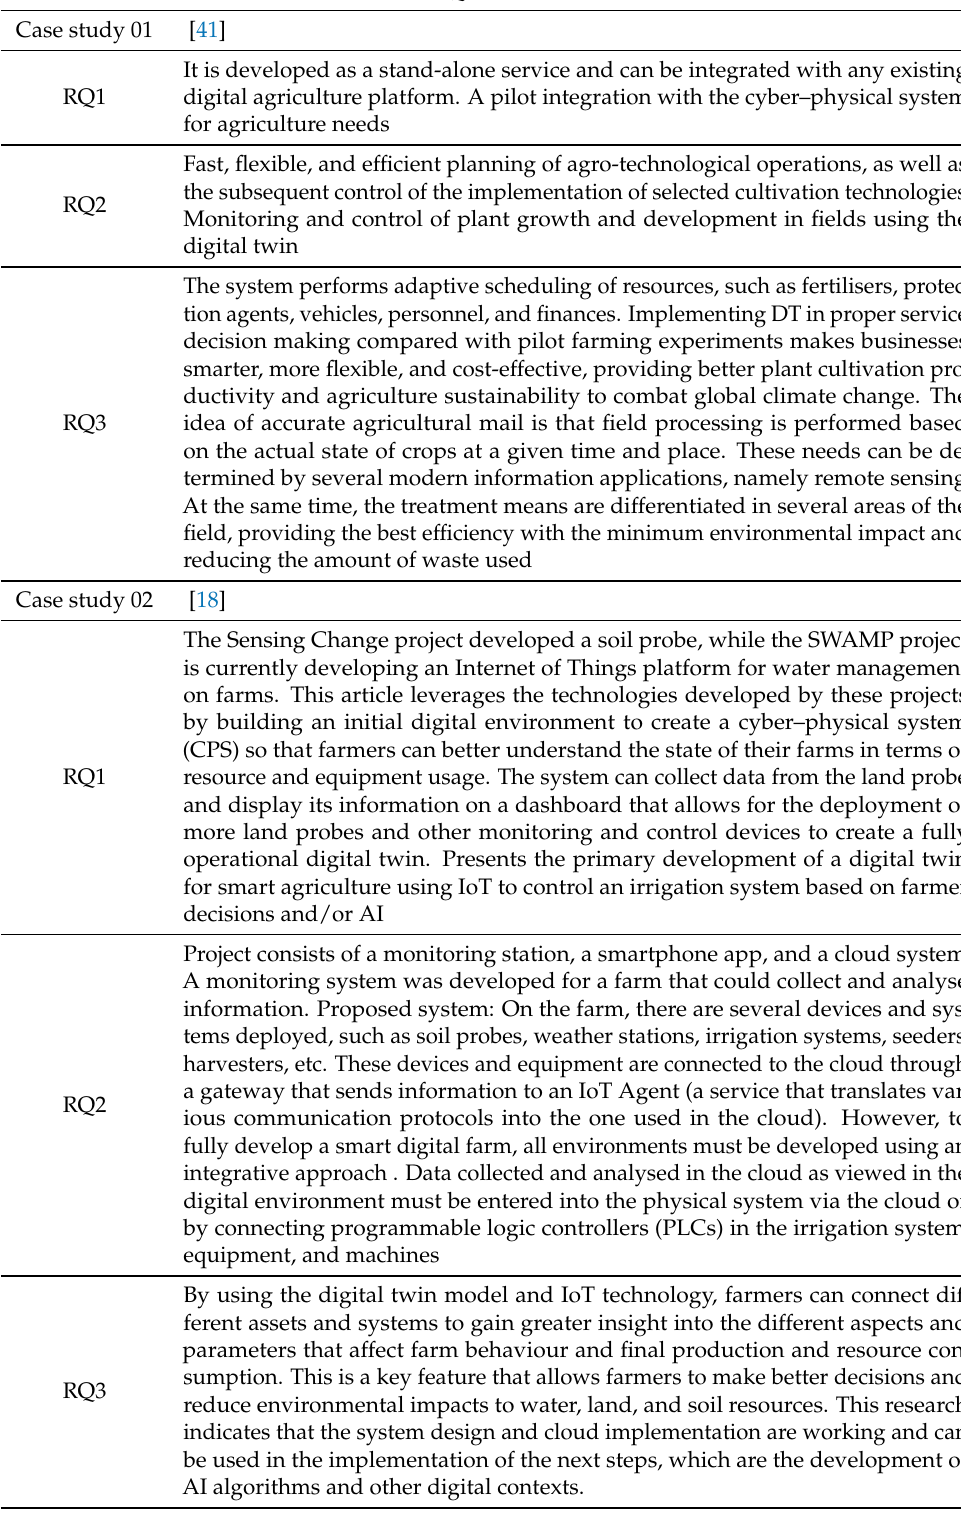
Table 16. Research questions